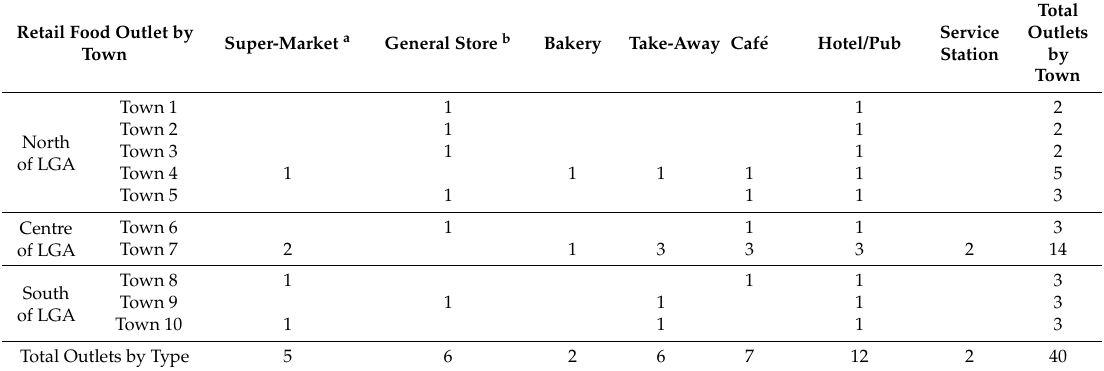
Table 3. Number and type of retail food outlet surveyed across the Local Government Area (LGA).